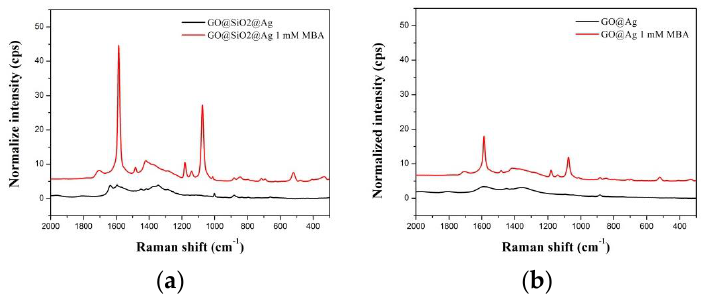
Figure 3. SERS spectra of ( a ) GO@SiO 2 @Ag NPs and ( b ) GO@Ag NPs in EtOH solution with and without 1 mM 4-mercaptobenzoic acid. GO concentration is 1 mg/mL, laser power is 10 mW, wavelength is 532 nm, integration time is 5 s, and laser spot is 2 µm.